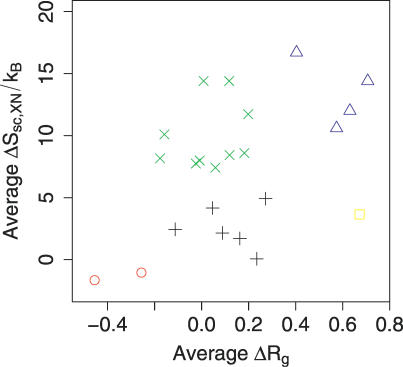
SCE of NMR and X-Ray Structures versus RgAverage SCE difference between X-ray and NMR structures (ΔSXN) versus the average difference of radius of gyration between X-ray and NMR backbones (ΔRg) for the 23 proteins.×, proteins whose X-ray structures have much higher SCE than but similar Rg to the corresponding NMR structures.Δ, proteins whose X-ray structures gain considerable SCE by packing a little looser.○, proteins whose X-ray structures pack tighter than NMR structures but with comparable SCE.+, small proteins of which both ΔRg and ΔSXN are small.